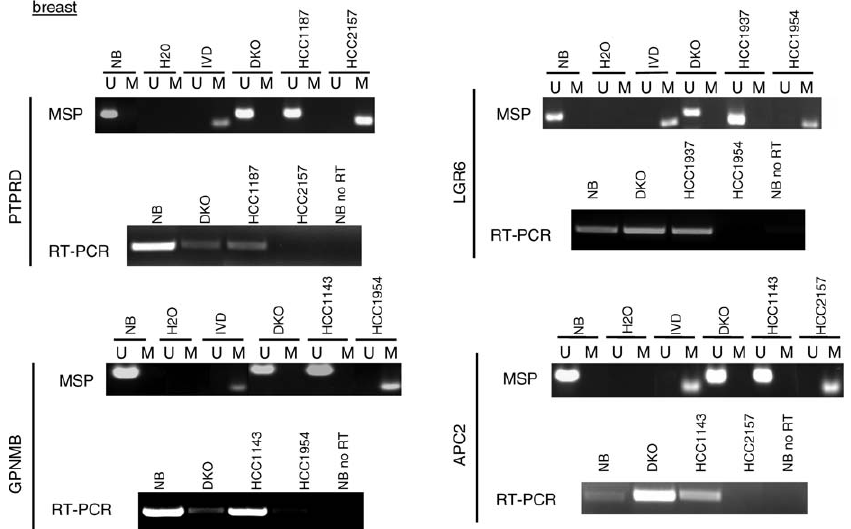
Figure 2. Common Gene Targets of Mutation and Hypermethylation in Breast Cancer MSP and RT-PCR expression analysis of selected genes. Each set of MSP and expression analyses are labeled with the corresponding gene name. U denotes the unmethylated band, and M denotes the methylated band. In vitro methylated DNA (IVD) was used as a positive control for methylation. cDNA from normal breast (NB) and normal colon (NC) (Figure 3) was used to determine the expression of the genes in normal tissue. DKO corresponds to DNMT 1/3b double knockout HCT116 cells. All RT-PCR experiments were performed in parallel without reverse transcriptase as a control, and in all cases, no PCR product was generated (unpublished data). The control experiment performed without RT for normal breast is shown (NB no RT) for each gene. RT-PCR was performed for all cancer lines with beta-actin primers to control for the amount of cDNA (Figure 3, bottom).